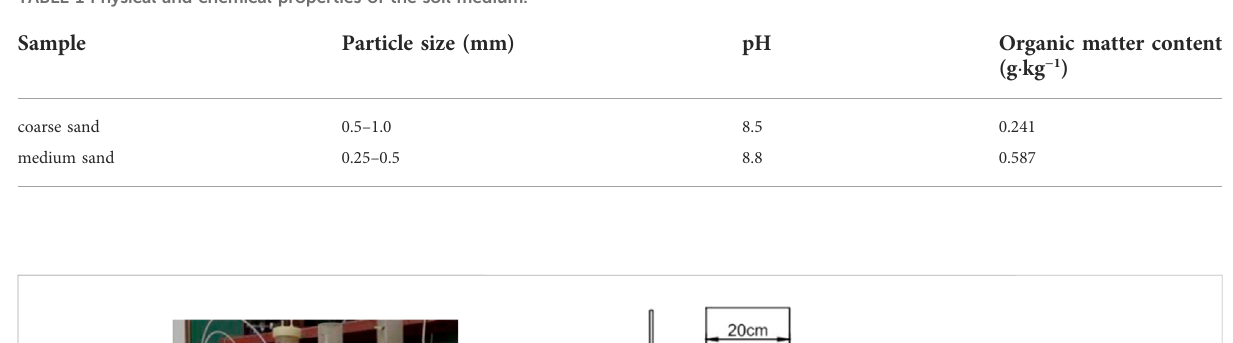
TABLE 1 Physical and chemical properties of the soil medium.